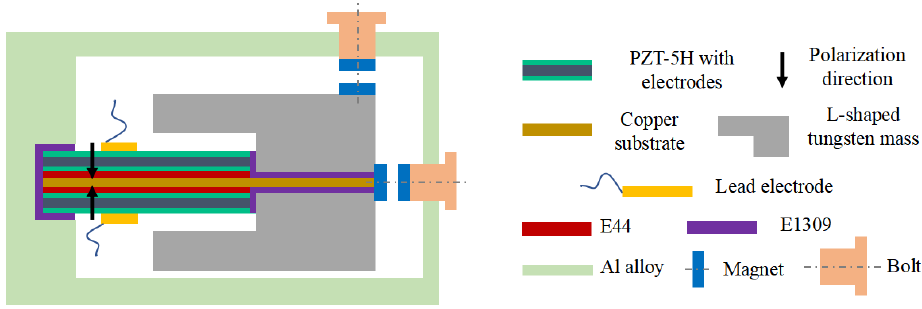
Figure 1. Tunable PVEH structure diagram.